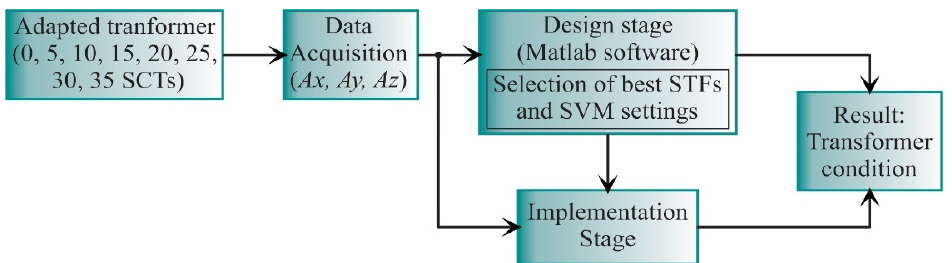
Figure 3. General block diagram for the proposed